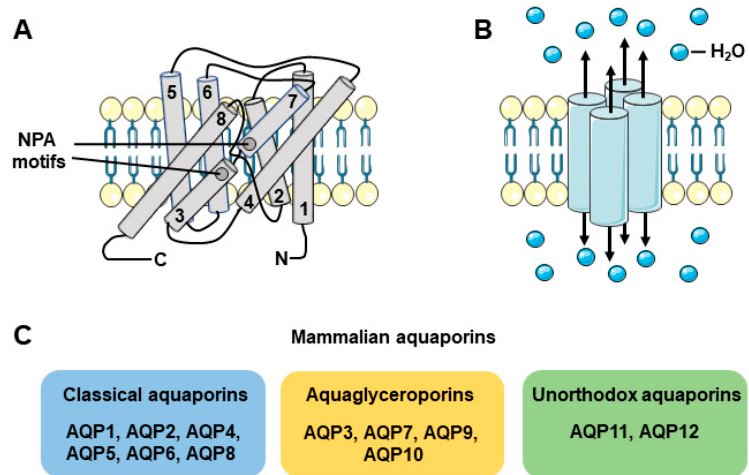
Figure 1. Characteristics and classification of AQPs. A : AQPs are made of six transmembrane helices and two short helices containing the NPA motifs for the classical AQPs and aquaglyceroporins, or NPC motifs for unorthodox AQPs. B : AQPs need to associate as tetramers to be functional. C : AQPs are subdivided into the classical AQPs, the aquaglyceroporins and the unorthodox AQPs.